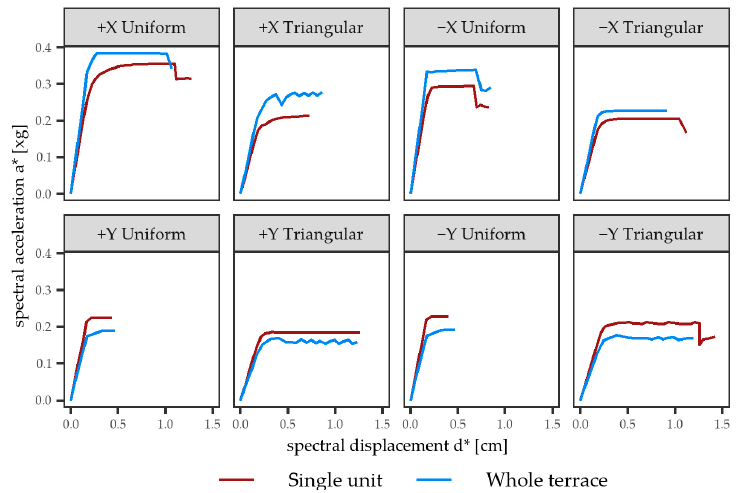
Figure 12. Normalized pushover analyses of as-built models (single unit and whole